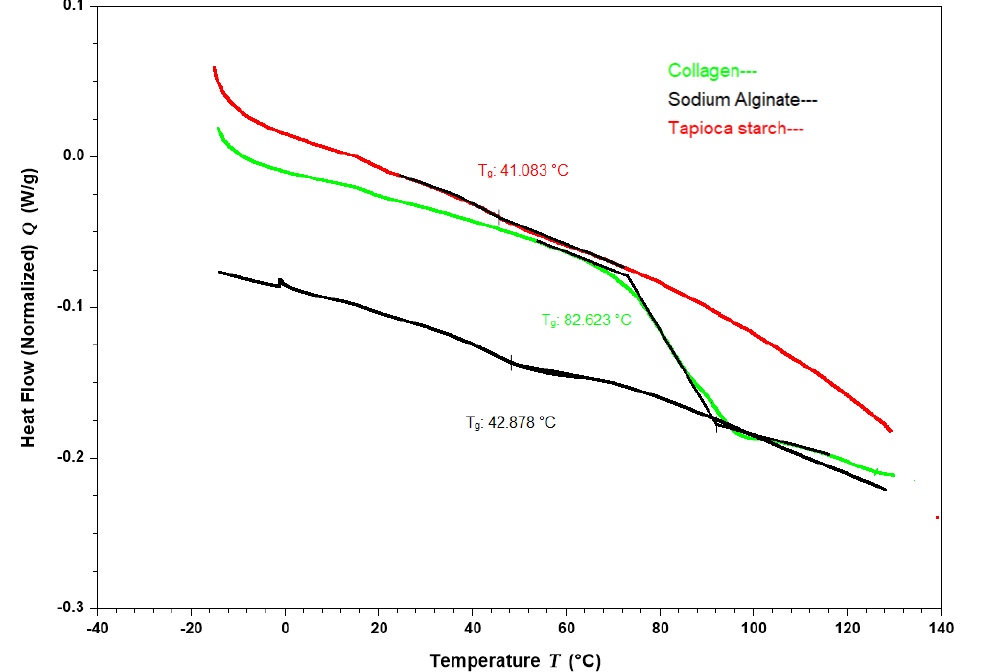
Figure 4. Glass transition of film-forming polymers: collagen ( ), sodium alginate ( ), and tapioca starch (